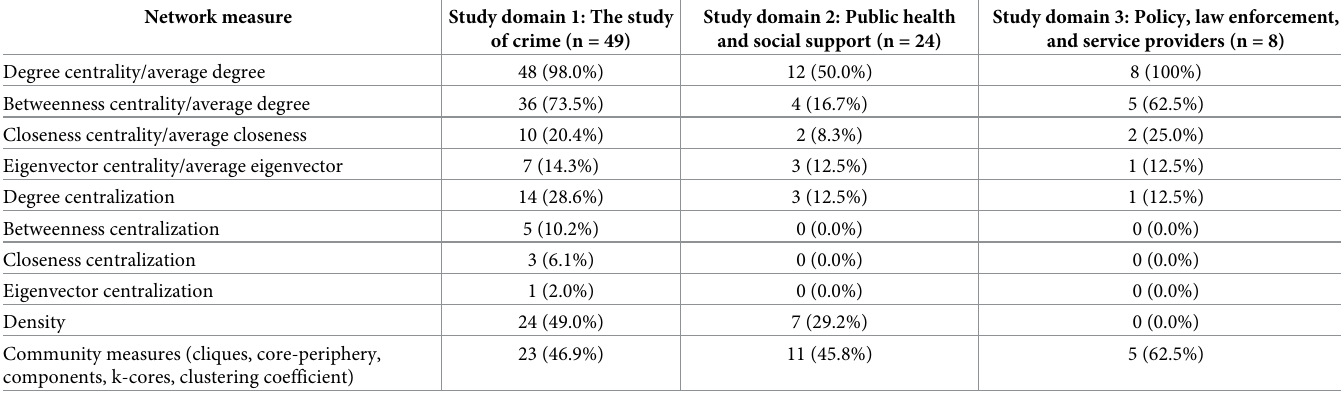
Table 3. Frequency of measures by study